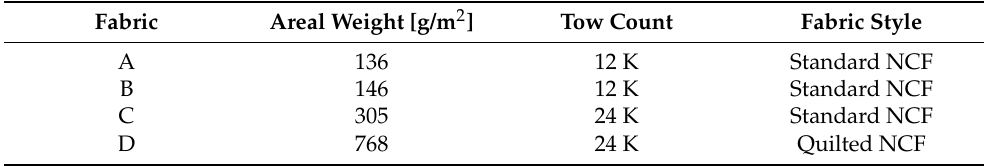
Table 1. Comparison of properties for the different fiber beds. NCF, non-crimp carbon fabric.